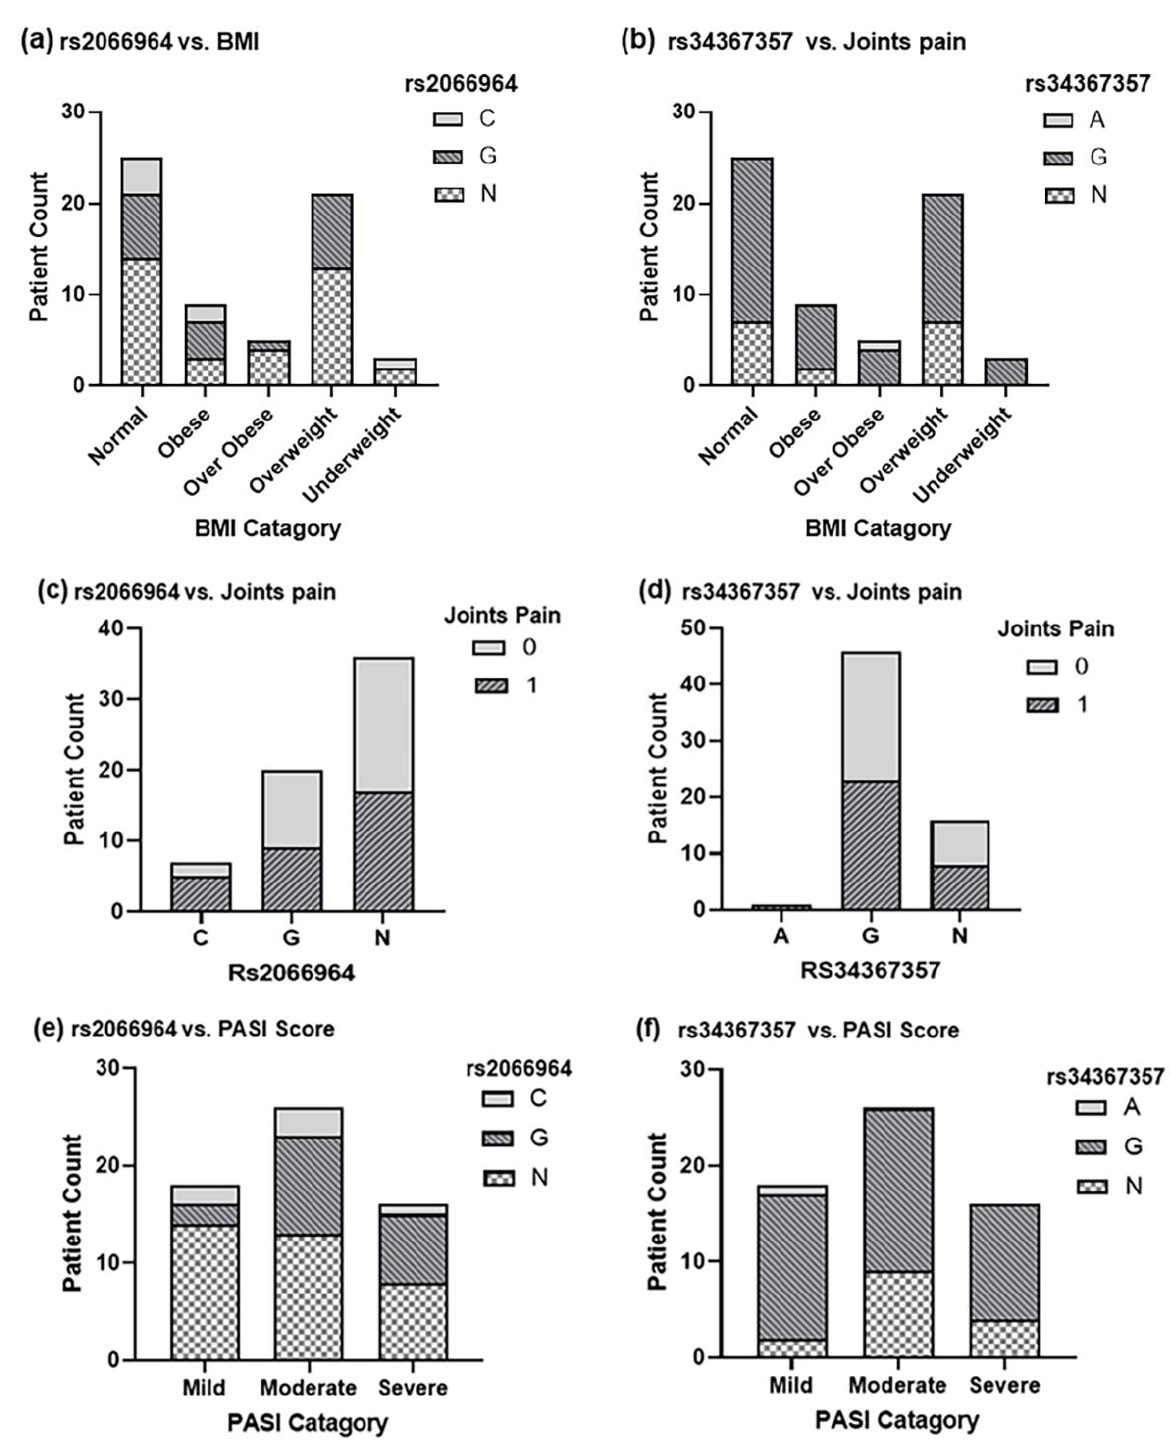
Figure 3. Distribution of different genotypes in the psoriatic patients. ( a ) Bar chart shows the distribution of rs2066964 genotypes in the psoriatic patients in different BMI categories. ( b ) Bar chart shows the distribution of rs34367357 genotypes in the psoriatic patients in different BMI categories. ( c ) Bar chart shows the distribution of rs2066964 genotypes in the psoriatic patients with and without joint pains. ( d ) Bar chart shows the distribution of rs34367357 genotypes in the psoriatic patients with and without joint pains. ( e ) Bar chart shows the distribution of rs2066964 genotypes in the psoriatic patients in different PASI score categories. ( f ) Bar chart shows the distribution of rs34367357 genotypes in the psoriatic patients in different PASI score categories.